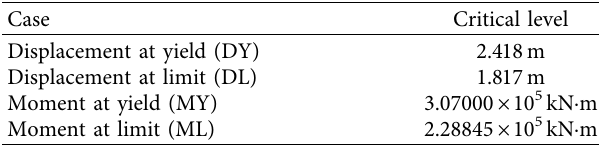
Figure 6: Relation between the nacelle displacement and tower base stress from static pushover analysis. Table 4: Specified critical